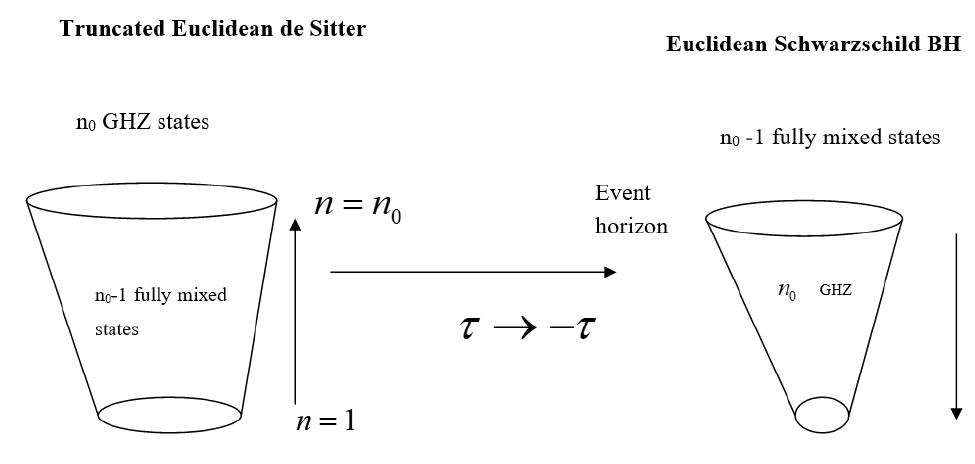
Figure 12. From truncated Euclidean de Sitter to Euclidean Schwarzschild